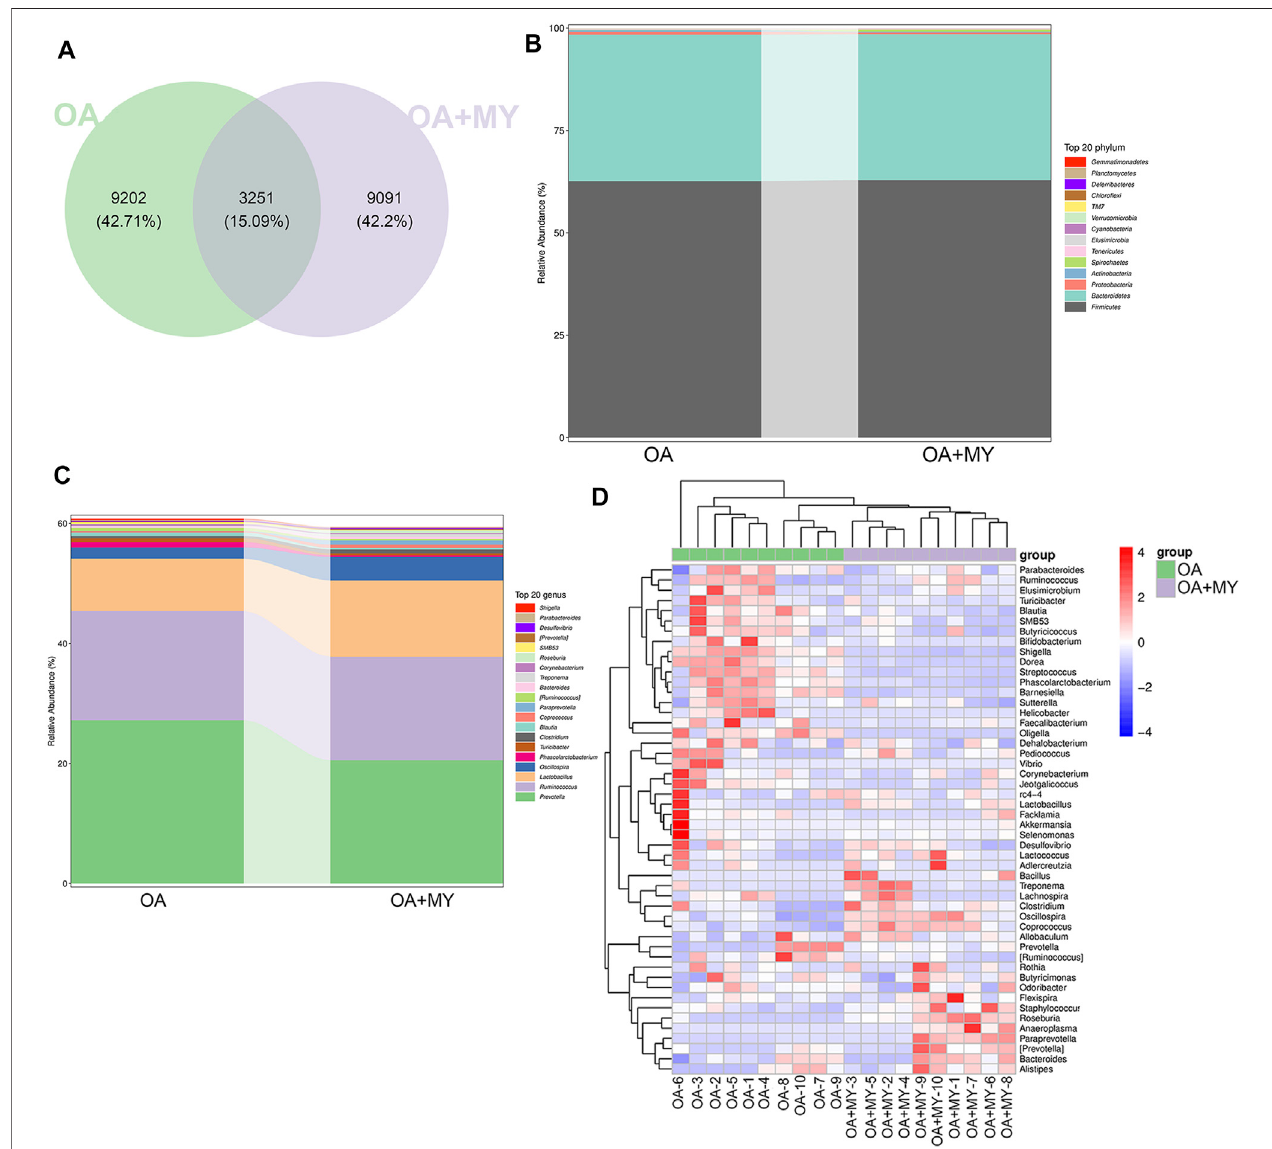
FIGURE 3 | Effects of MY on the gut microbial composition in OA. (A) Venn diagrams of operational taxonomic units (OTUs) abundance in the OA and OA+MY groups. (B) Rabundanceoftop20phylabetweentheOAandOA+MYgroups. (C) Relativeabundance oftop 20generabetweentheOAandOA+MYgroups. (D) Heat map of prominent OTUs (top50) assigned to the genus level among each sample.